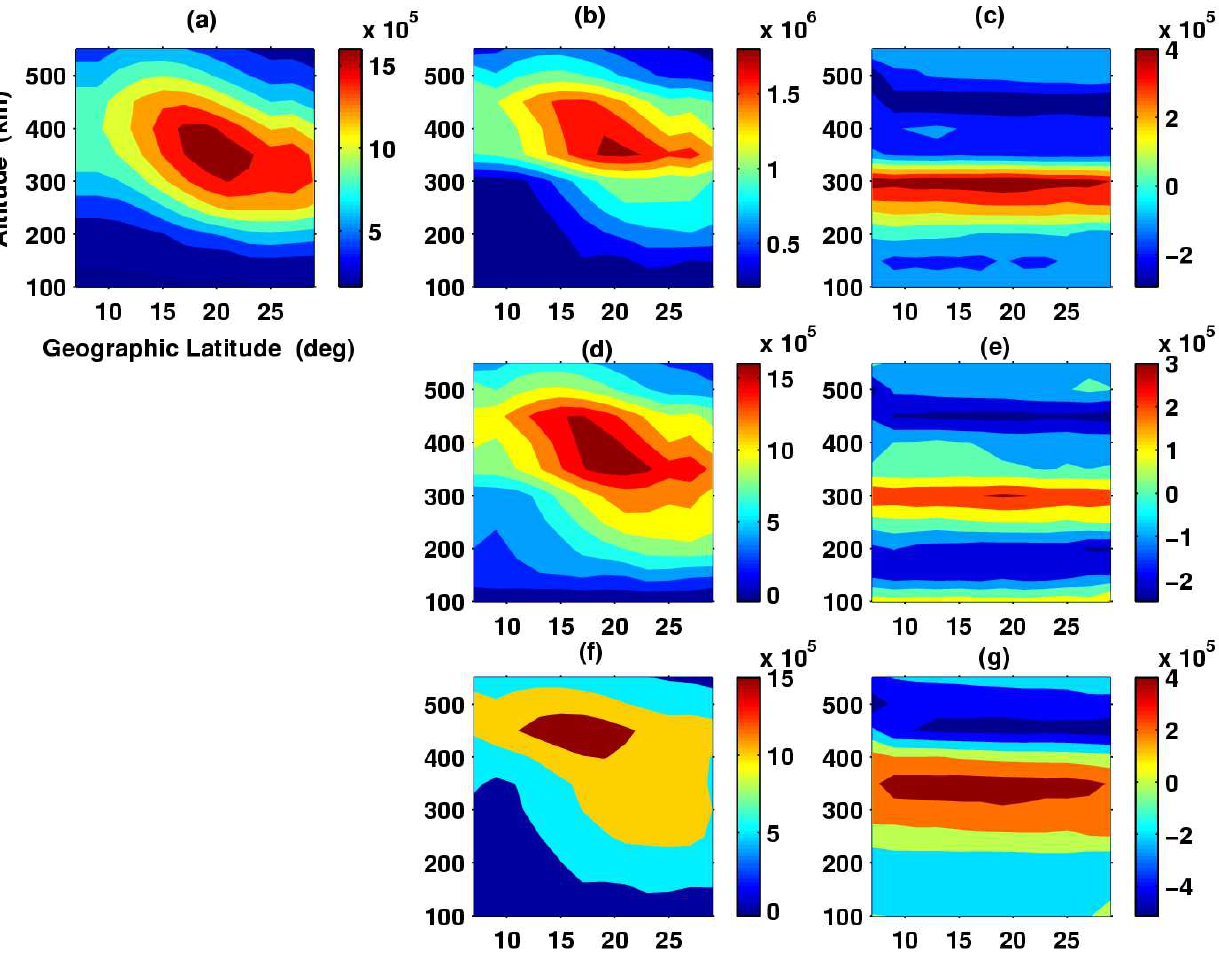
Fig. 10. ( a ) Same as Fig. 8a. ( b ) The reconstruction with random errors ranging from 0.001% to1% of the average TEC added to input data and with the 3 lowest singular values truncated. ( d ) The reconstruction with random errors ranging from 0.001% to1% of the average TEC added to input data and with the 4 lowest singular values truncated. ( f ) The reconstruction with random errors ranging from 0.001% to1% of the average TEC added to input data and with the 5 lowest singular values truncated. ( c , e , g ) The corresponding differences from the model in Fig.